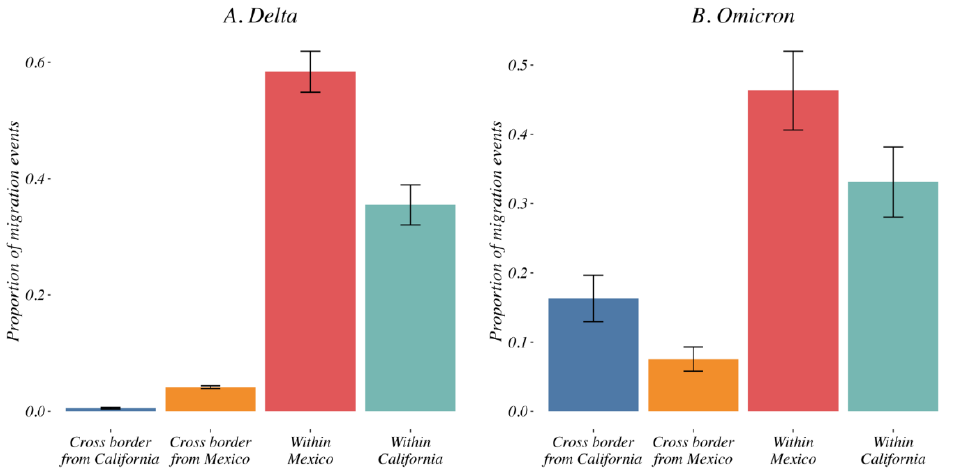
Figure 6. Relative contribution of national vs. international transmission events to the Delta ( A ) and Omicron ( B ) epidemics. The variant migration events across the border (from California toward Mexico and from Mexico toward California in blue and orange respectively) accounted for 3.4% and 23% of all inferred migration events for Delta and Omicron, respectively. Migration events within California and within Mexico are shown in red and green. See Supplementary Figure S9 for a description of these contributions over time.